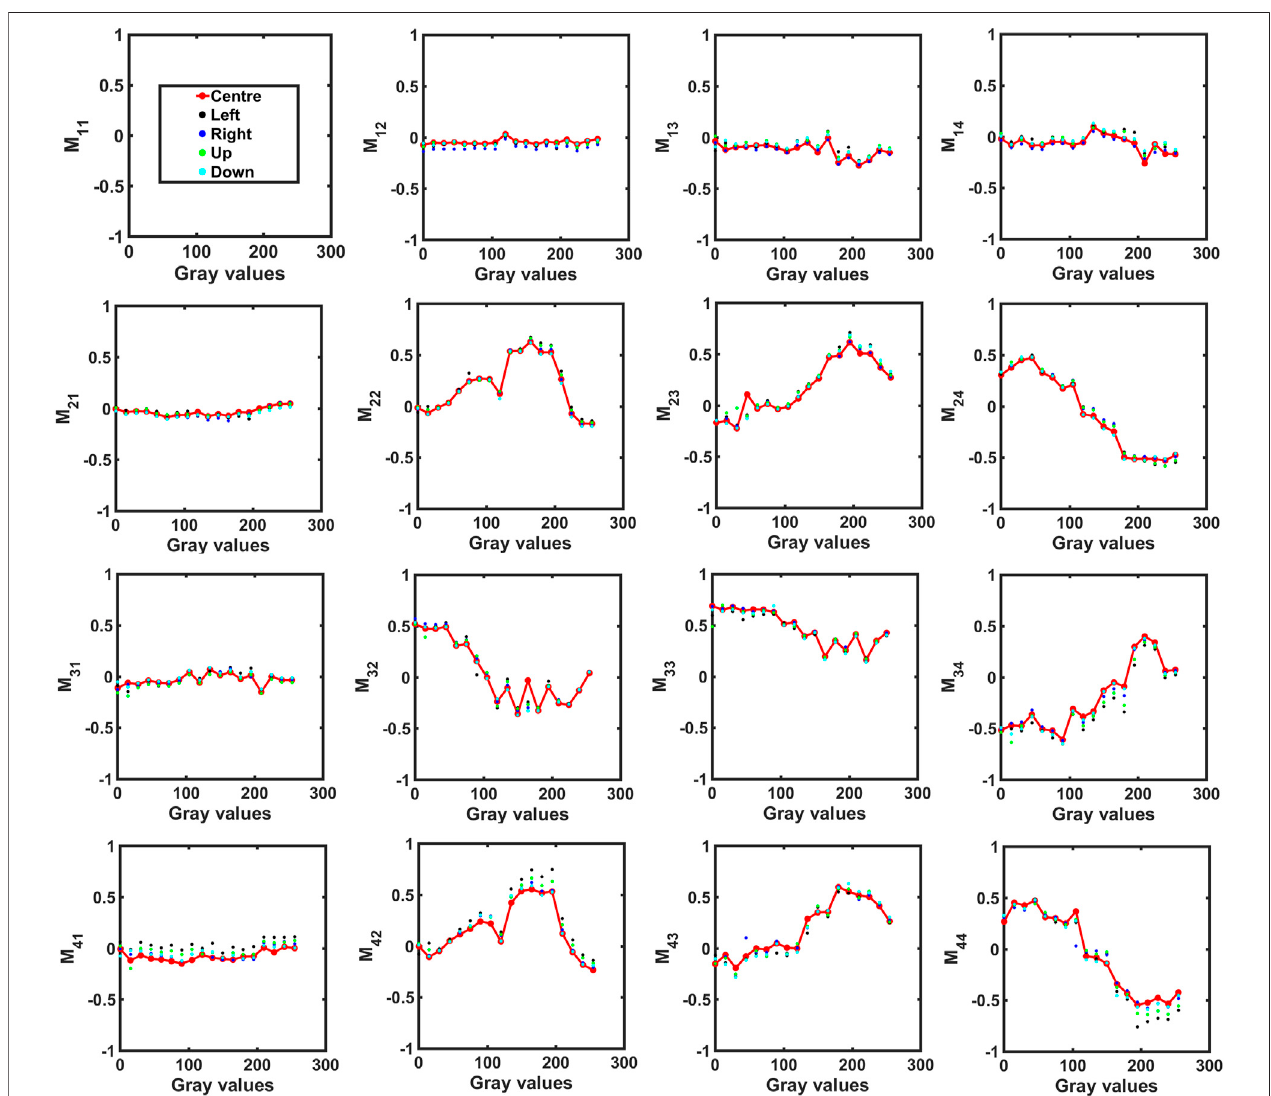
FIGURE 3 | Mueller matrix elements as a function of gray values of SLM (Holoeye, LC-R 720) at different spatial locations of the SLM display. Different color dots (red, black, blue, green, and sky-blue) represent the Mueller matrix elements at various spatial locations (center, left edge, right edge, up, and down), respectively. All Mueller matrix elements are normalized with respect to M 11